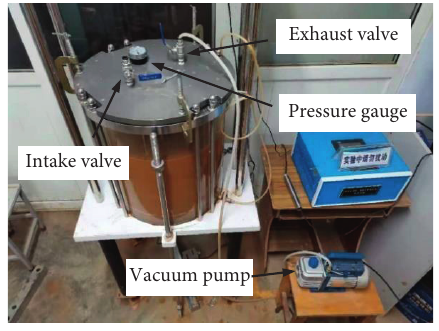
Figure 5: Vacuum